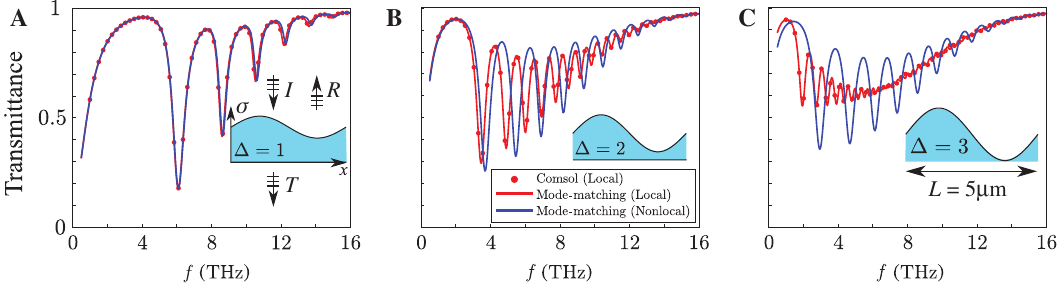
Figure 3: Nonlocality leads to saturation of the density of states in a singular graphene metasurface. Local (red) and nonlocal (blue) transmittance spectra for plane wave illumination through the graphene metasurface at normal incidence, obtained with the mode-matching (continuous lines) and finite-element method (dots) for three increasingly singular metasurfaces corresponding to Δ = 1 (A), Δ = 2 (B), and Δ = 3 (C), respectively. The nonlocal contribution, which is negligible away from the singular regime, becomes dominant as the singular limit is approached, opposing the merging of surface plasmon modes.